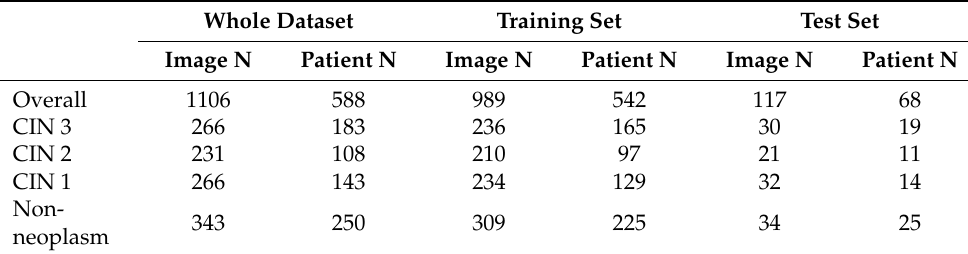
Table 1. Data composition for the first splitting of the training and test datasets. Whole Dataset Training Set Test Set Image N Image